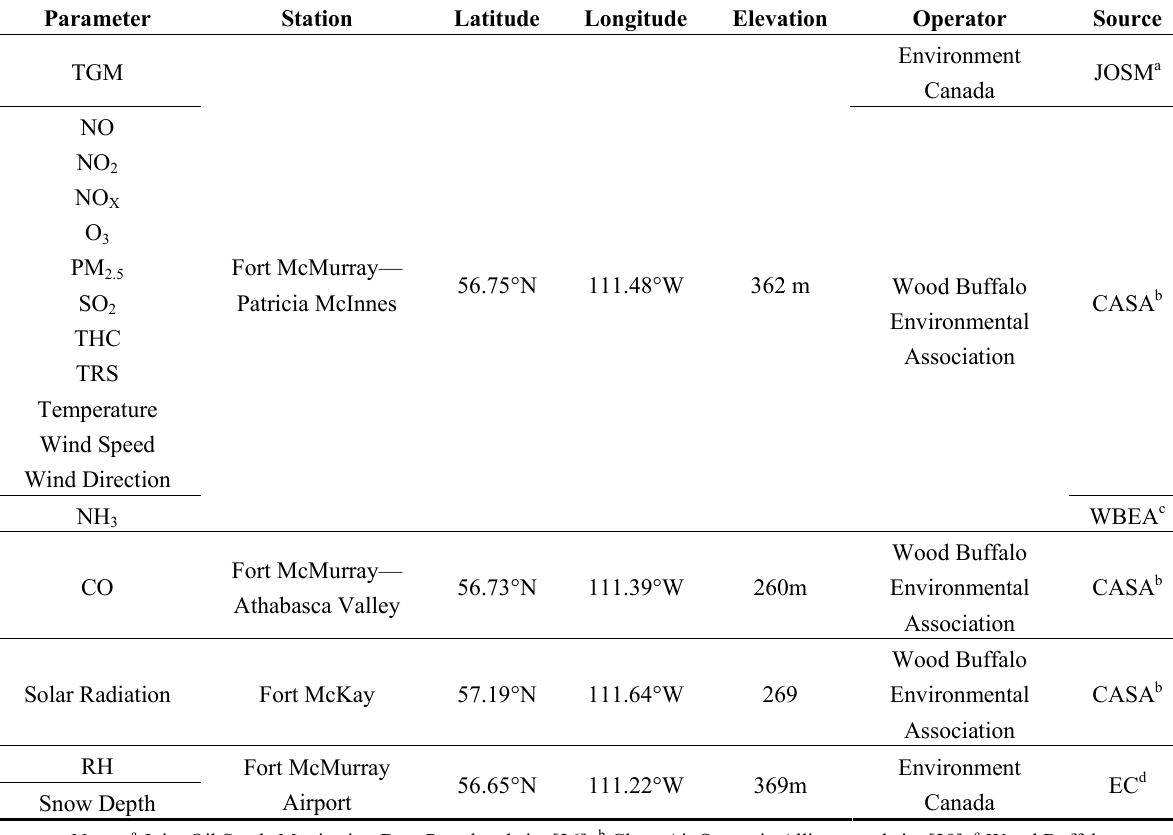
Table 6. Summary of data